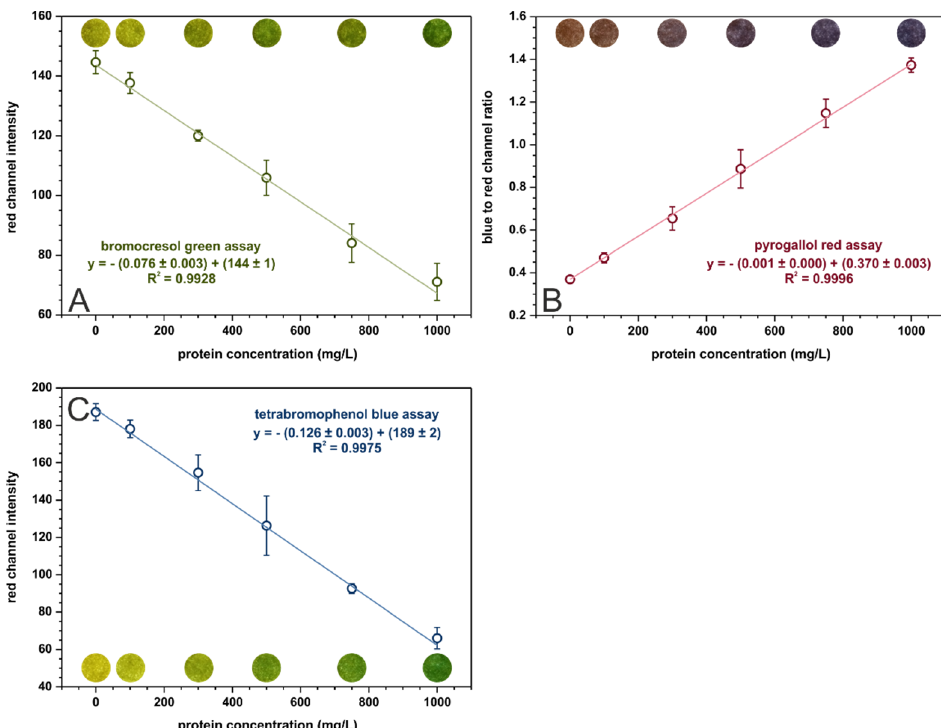
Figure 2. Calibration dependencies for ( A ) bromocresol green, ( B ) pyrogallol red, and ( C ) tetrabromophenol blue assays registered in the optimal conditions, n = 3. The colorful spots are the actual photos of the detection zones of paper-based sensors after the introduction of sample with an appropriate BSA concentration. Table 3. Analytical parameter comparison for paper-based sensors operating according to the previously optimized assays. Analytical